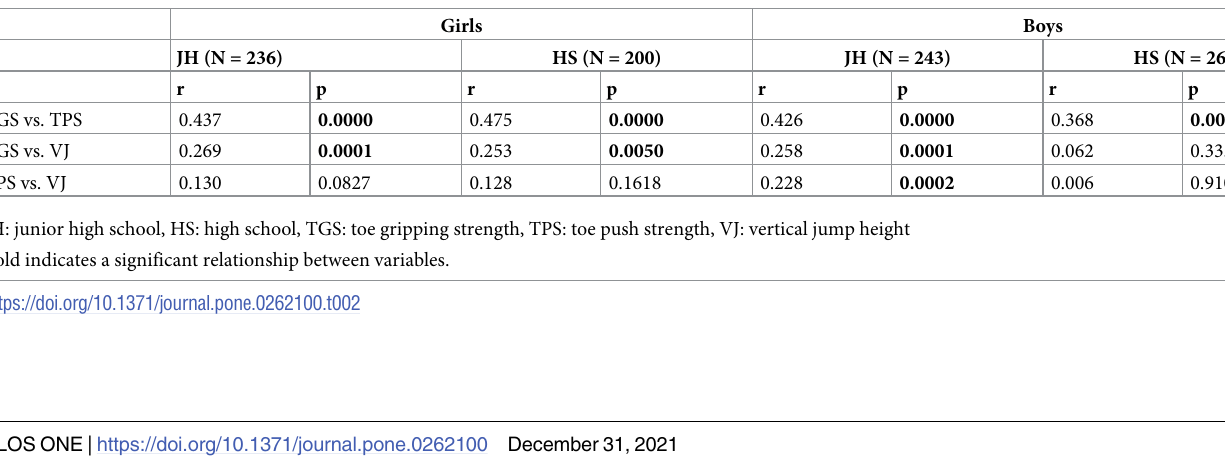
Table 2. Pearson’s correlation coefficients and the p-values between TGS, TPS, and VJ in each